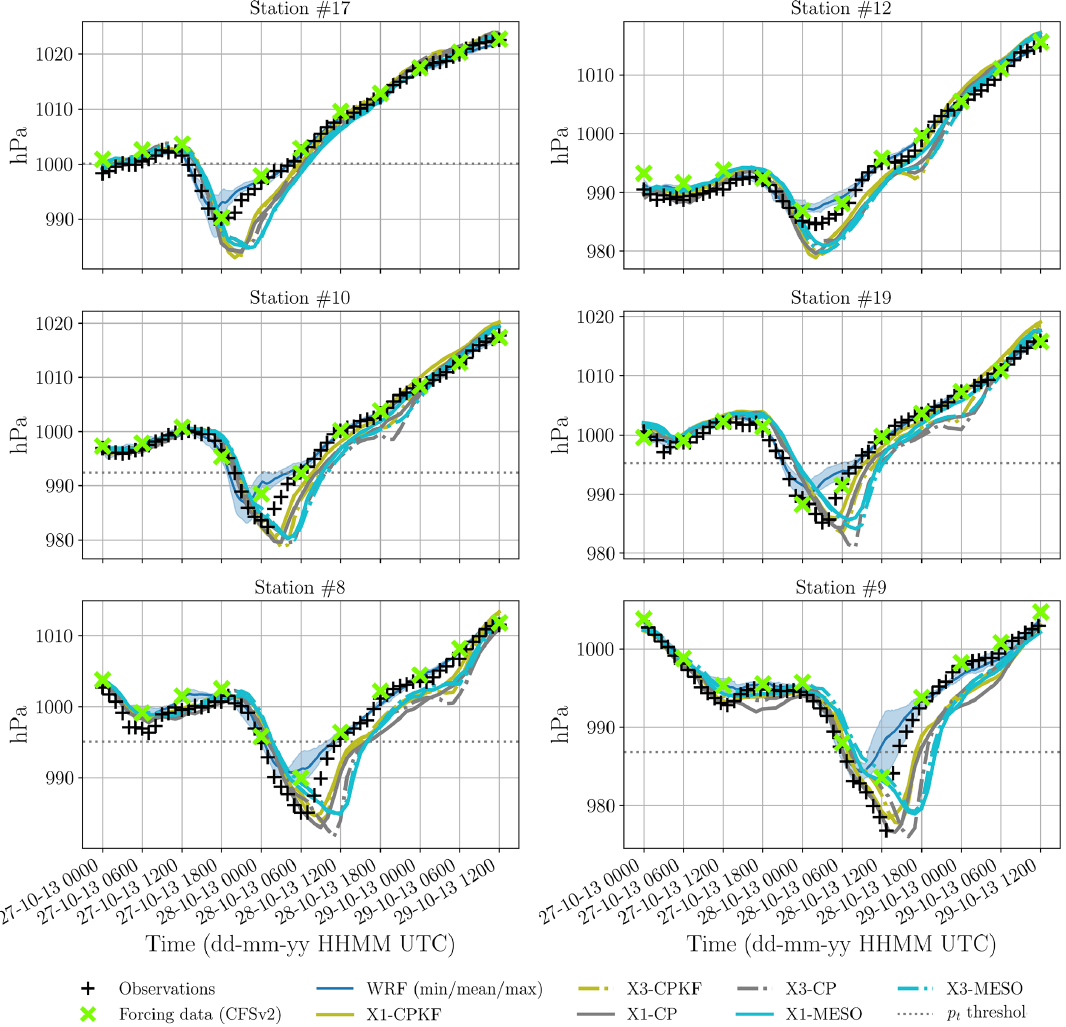
Figure 5. Time series of sea level pressure at the six buoy locations obtained from observations, CFSv2 forecast data, the extended WRF simulations described in Sect. 2.3 and the six MPAS configurations. To highlight the difference between the individual MPAS configurations and WRF, the results from the seven WRF configurations are aggregated and represented as average values and an interval enclosing minimum and maximum values for each data point. The naming of the MPAS configurations follows the naming convention introduced in Table 3.